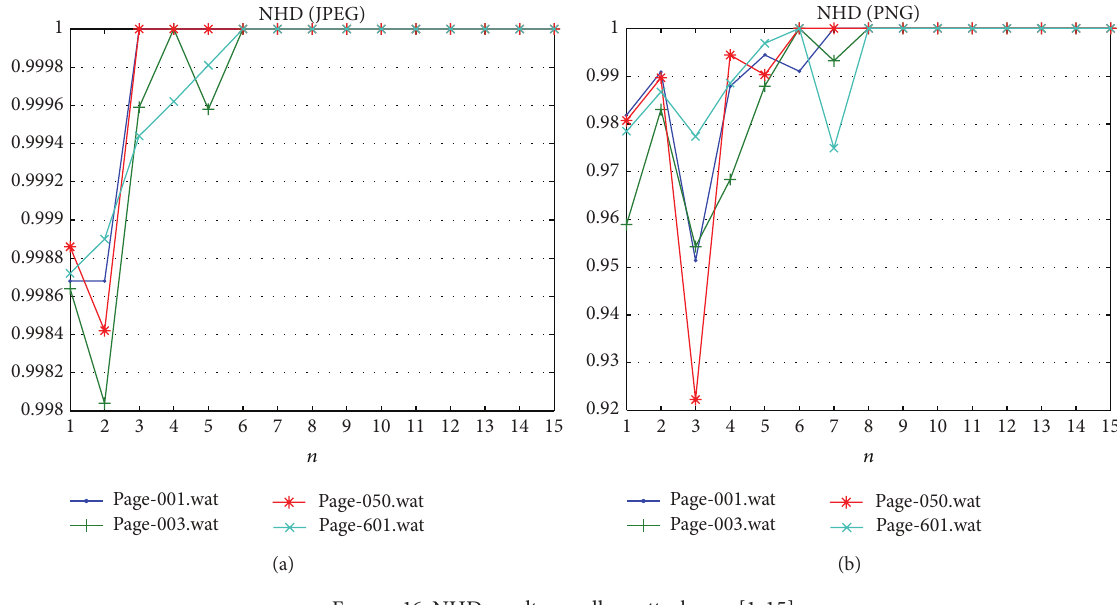
Figure 16: NHD result on collage attack, 𝑛 = [1, 15]